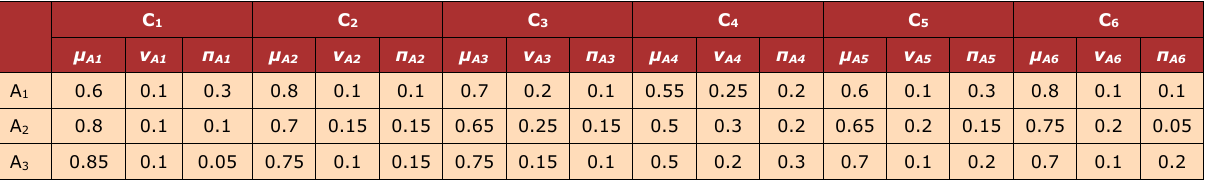
Table 2. Demostration of degrees which satisfy and not satisfy criterion C j in project A